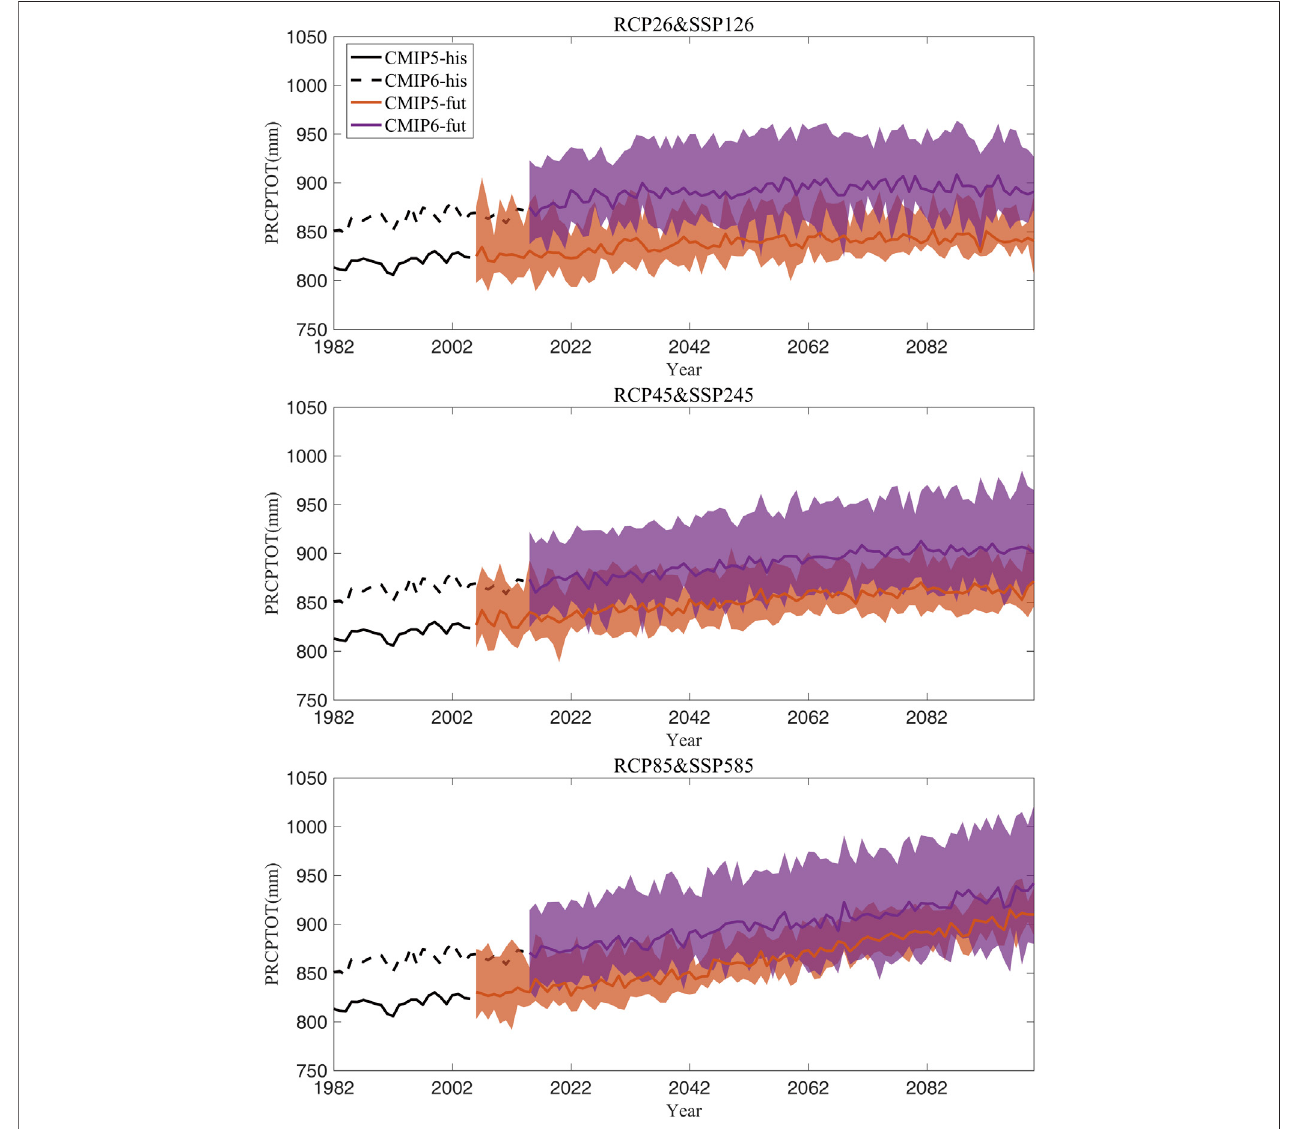
FIGURE 13 | Global land-average multi-model mean PRCPTOT during 1982 – 2100 in CMIP5 and CMIP6. The shaded region shows the uncertainty range (between the 25 quantiles and the 75 quantiles).